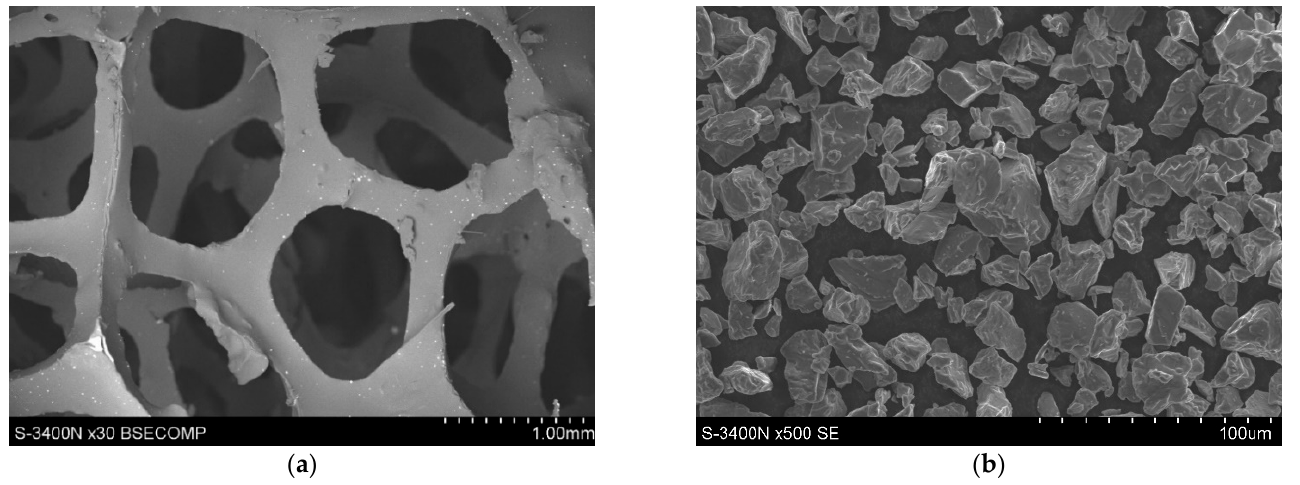
Figure 2. Microstructure of ( a ) spatial structure of PU foam; ( b ) Ti powder (SEM). Table 1. Chemical compositions of suspension used to produce spatial Ti-C reinforcement.